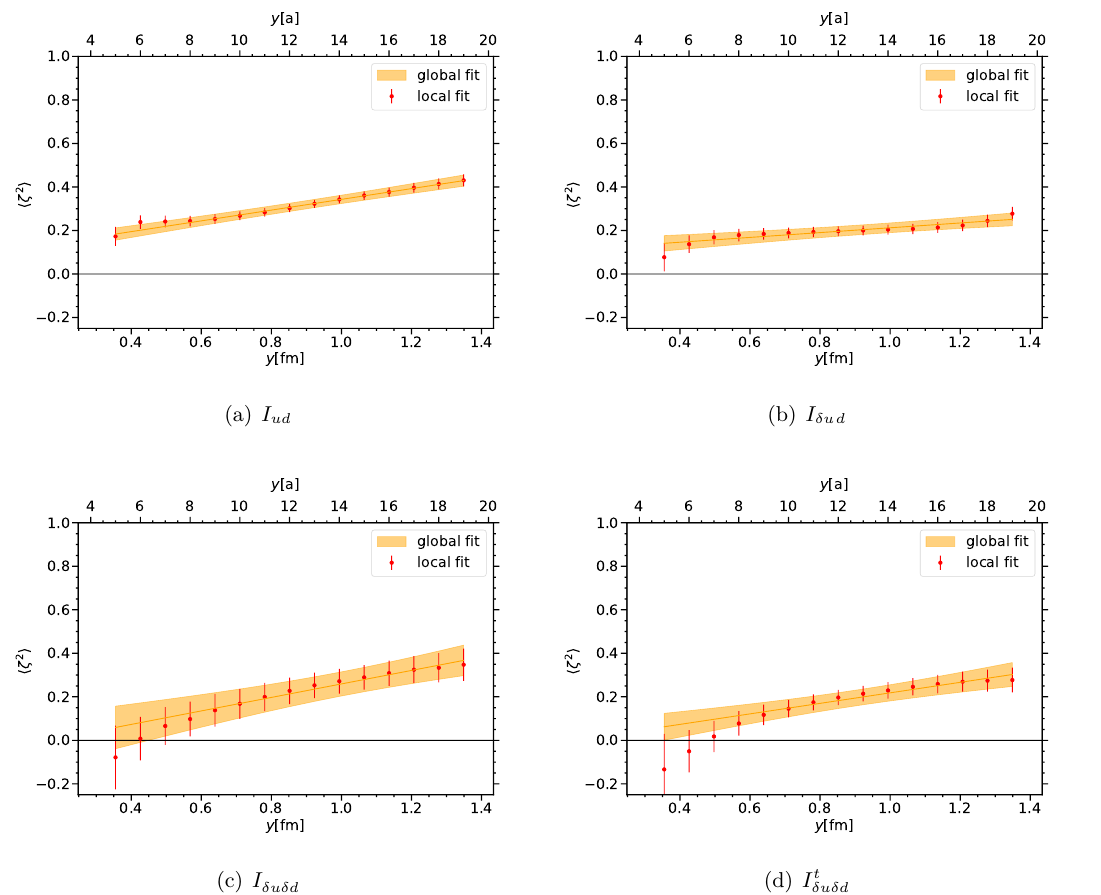
Figure 28 . Values of the moment h ζ 2 i ( y 2 ) associated with I ( y 2 , ζ ) , extracted by local fits (data points) and the global fit